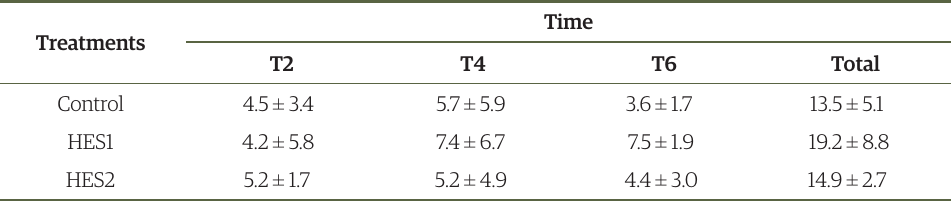
table 1. Mean values and standard deviations of the ingested volumes (L) of water (control) and hydroelectrolytes and energy replenishers 1 and 2 (HES1 and HES2) by horses undergoing gait training for a duration of one hour. Time Treatments T2 T4 Total